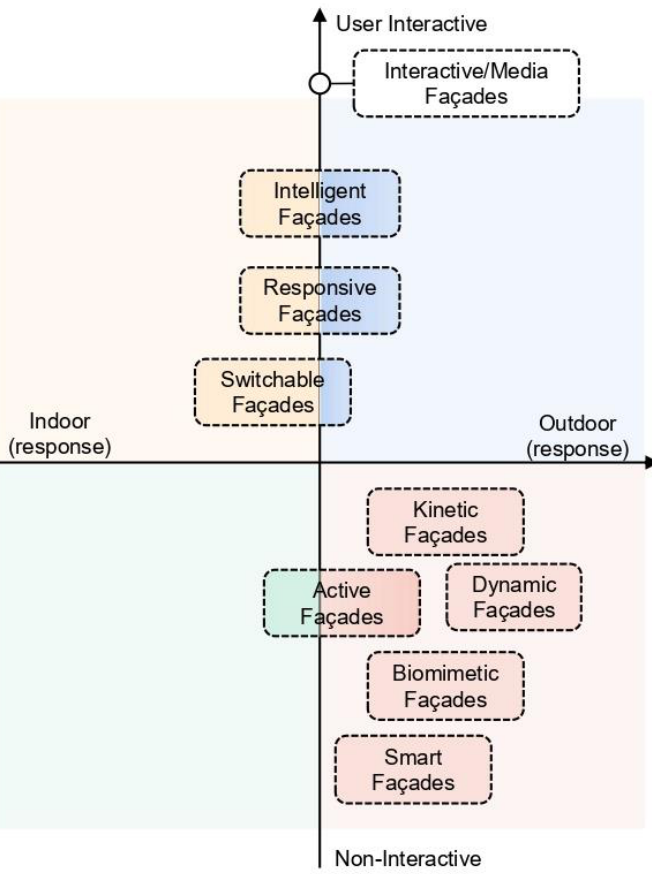
Figure 1. Main characteristics of adaptive façade typologies .